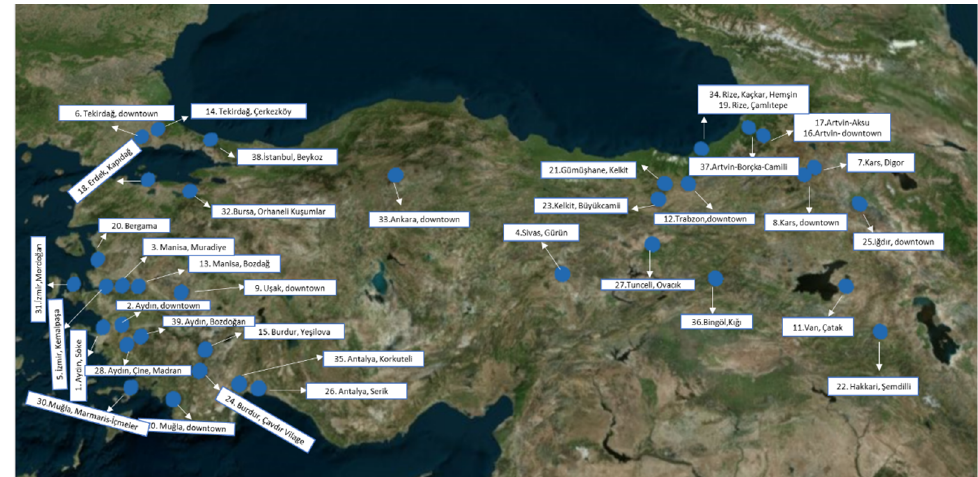
Figure 1. The exact locations of propolis samples collected from Turkiye [29].